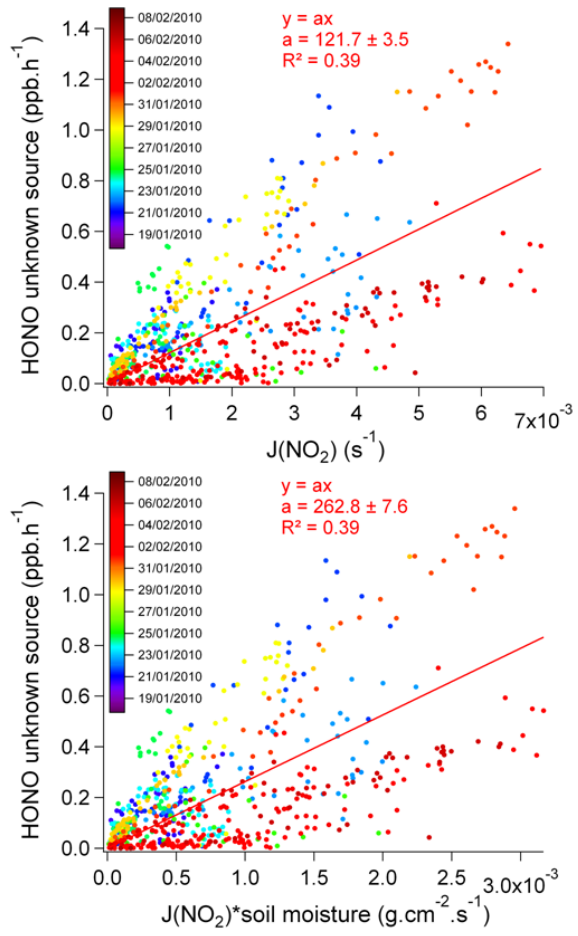
Fig. 14. Correlations between the unknown HONO source and measured J (NO 2 ) and the product between measured J (NO 2 ) and soil moisture measured at 5cm below ground surface, during the MEGAPOLI winter campaign at SIRTA observatory. The dots of both correlations have been coloured as a function of the